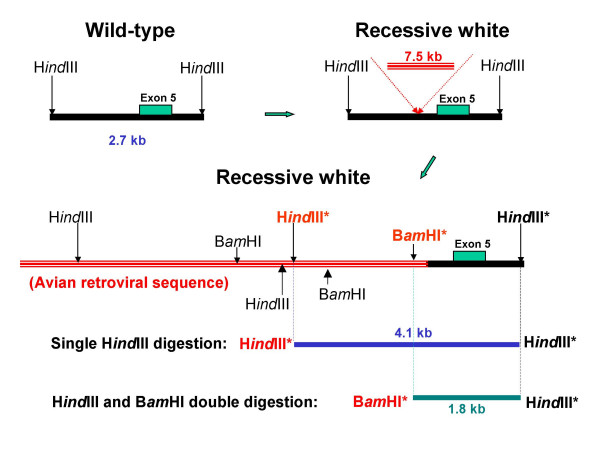
Explanation of the RFLP results obtained for the TYR gene in recessive white chickens according to the structure of intron 4. A 2.7 kb HindIII fragment was obtained in the wild type chicken after a single HindIII digestion and hybridization with an exon 5 probe. A 4.1 kb HindIII band and a 1.8 kb BamHI-HindIII band were obtained after HindIII single digestion and BamHI-HindIII double digestion in the recessive white mutation.